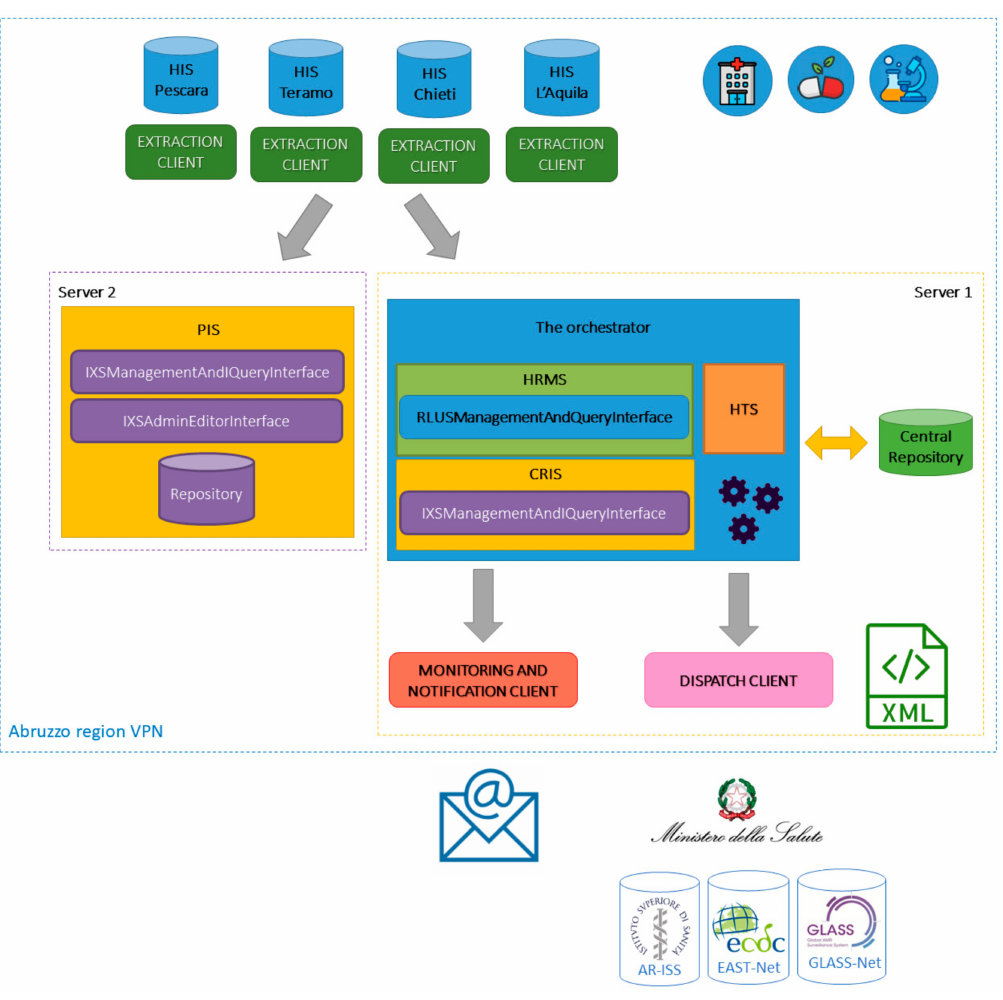
Figure 2. The overall